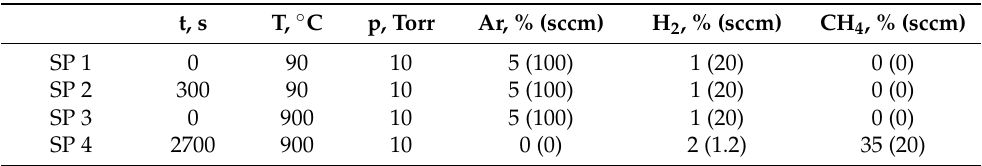
Table 1. Stages and corresponding process parameters in the cold-wall chemical vapor deposition (CW-CVD) chamber.